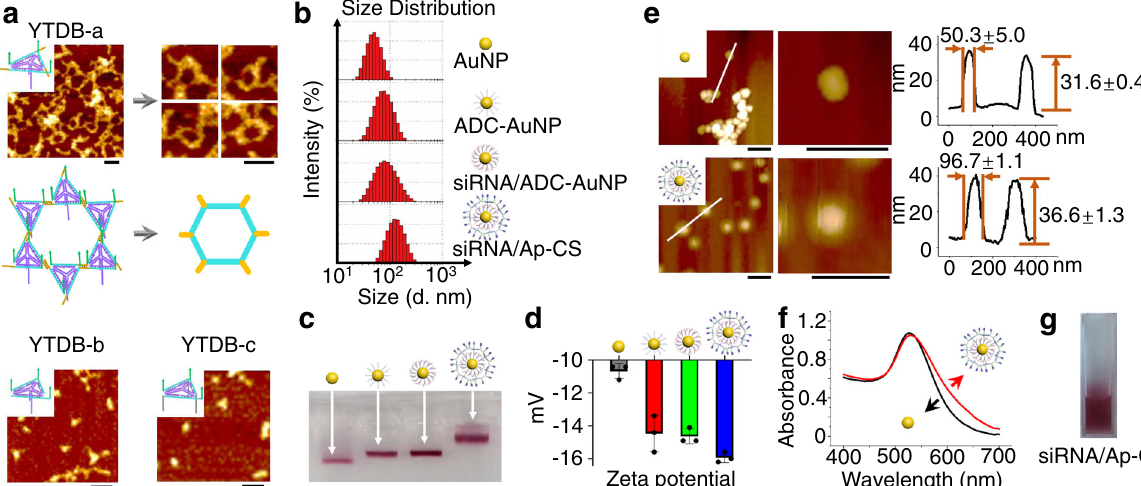
Fig. 2 Characterization of siRNA/Ap-CS Nanostructure. a AFM images of three Y-shaped backbone-rigidi fi ed triangular DNA brick (YTDB-a, YTDB-b, and YTDB-c). Inset: magni fi ed AFM images of YTDB-a. Scare bar is 50 nm. b Dynamic light scattering (DLS) analysis and c agarose gel electrophoresis to con fi rm the stepwise assembly of siRNA/Ap-CS. The red bands indicate the naked or DNA functionalized AuNPs. These experiments were conducted three times independently with similar results. d Zeta potential analysis of four nanostructures in panel c mentioned by DLS. The error bar represents the standard deviation (SD). The measured data are expressed as the means ± SD ( n = 3). e AFM images of naked-AuNPs and siRNA/Ap-CS. Middle panel: expanded view of a typical CS nanoparticle. Scare bar is 150 nm. Right panel: cross-section pro fi les of naked-AuNPs and siRNA/Ap-CS taken along the white line in the left AFM images. f UV − vis absorption spectrum of naked-AuNPs (black line) and siRNA/Ap-CS (red line). g Photographed image of siRNA/Ap-CS